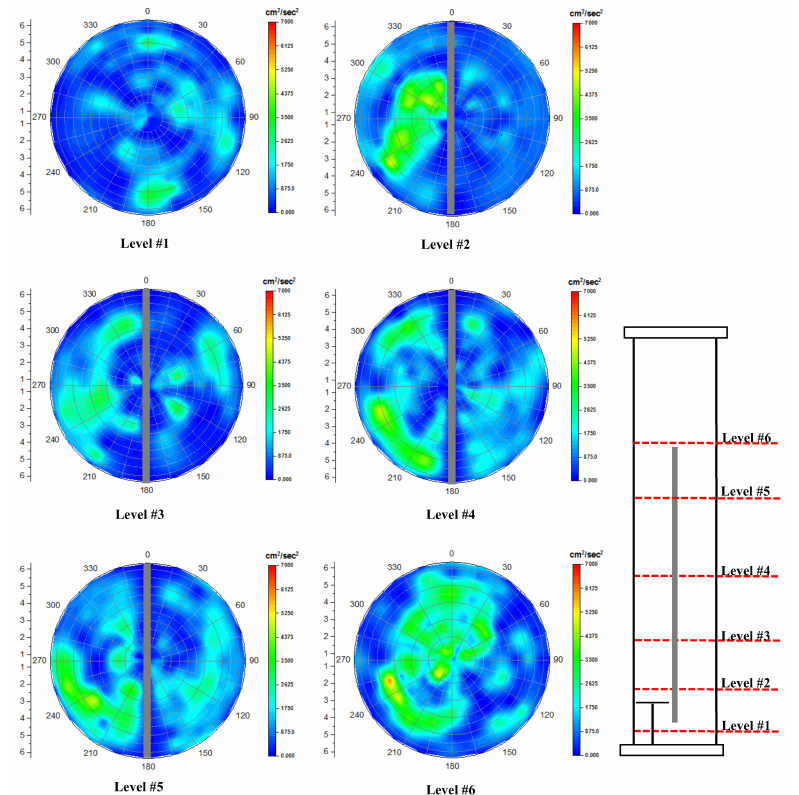
Figure 17. Cross-sectional distributions of shear stress at different heights of split airlift reactor operated under gas velocity of 2 cm/s.